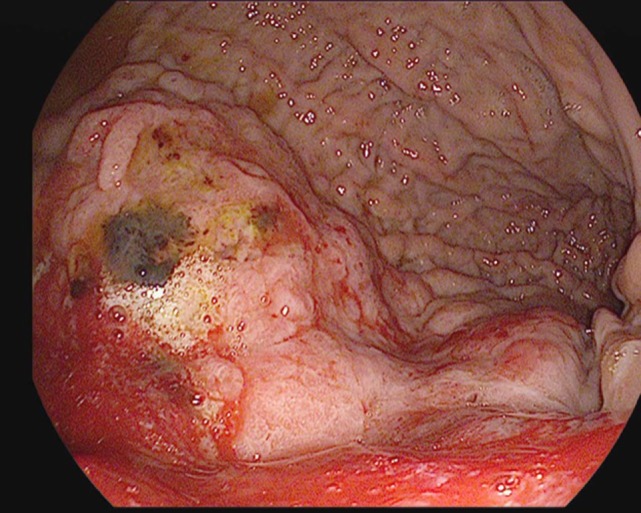
A large, friable, actively oozing fundic mass with extension into the cardia, found in a 69-year-old gentleman who underwent esophagogastroduodenoscopy (EGD) for anemia and melena. Pathology was consistent with gastric adenocarcinoma.